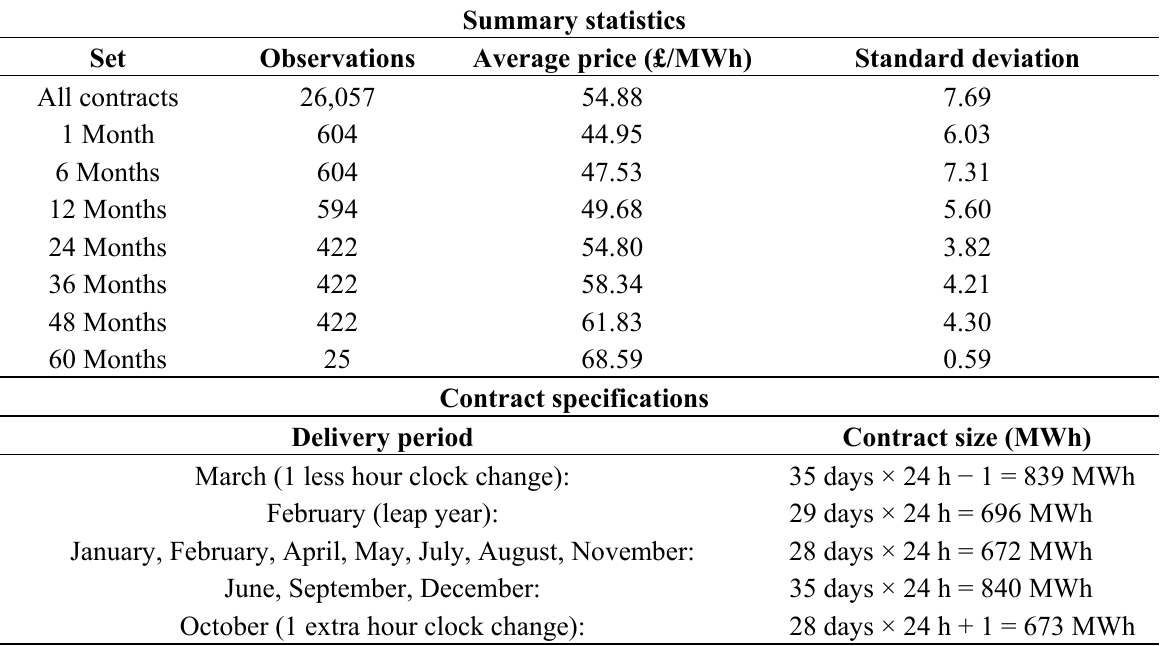
Table 1. UK electricity futures